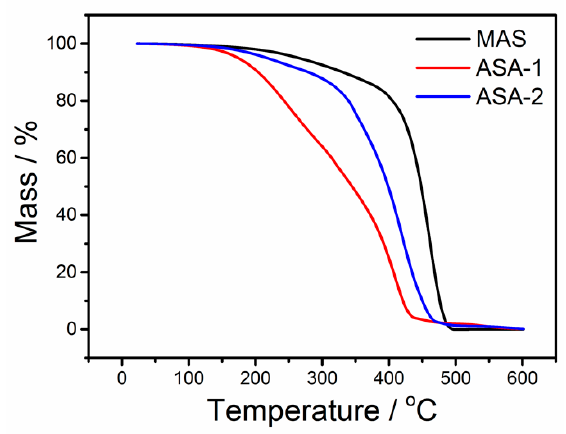
Figure 2. TG curves of the anti-stripping composites of MAS, ASA-1 and ASA-2. Table 6. Thermolysis temperature of anti-stripping composites of MAS, ASA-1 and ASA-2.